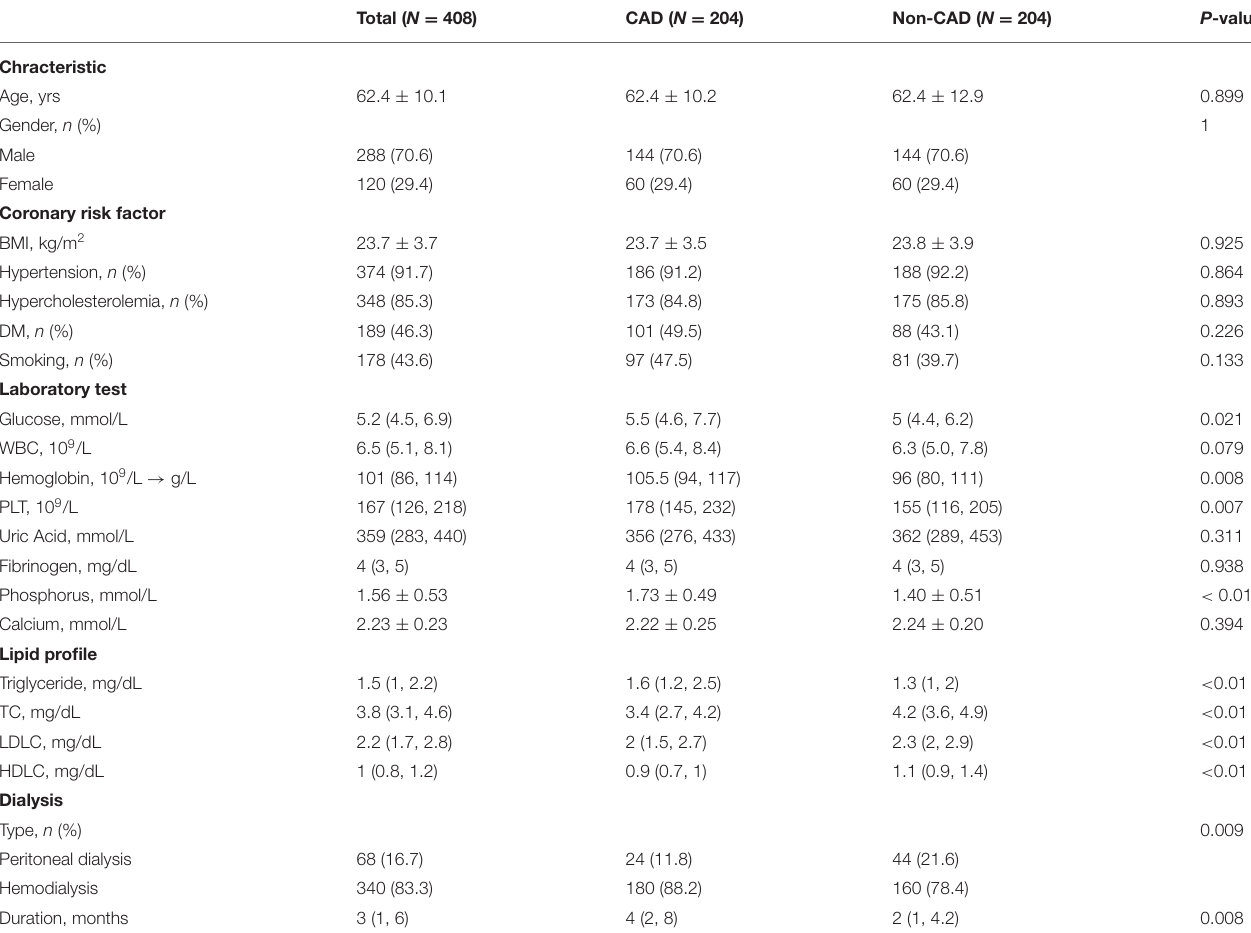
TABLE 1 | Baseline characteristics of dialysis end-stage renal disease (ESRD) patients with or without coronary artery disease